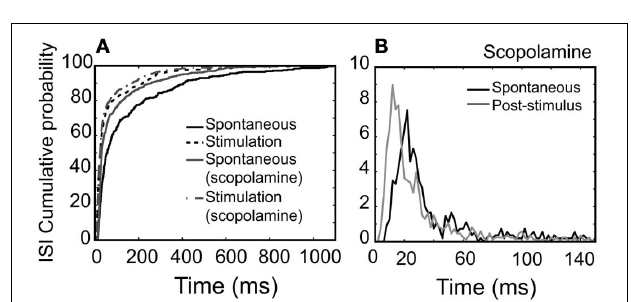
FIGURE 9 | NDB potentiation is not affected by scopolamine in a non-synchronized, rhythmically spiking unit (Figure 4). For this unit, scopolamine was dripped at 600 μ M. (A) Cumulative probability of ISI distributions in spontaneous or post-stimulus activity and the effect of scopolamine. (B) Plots showing ISI distributions after scopolamine treatments. Note that ISIs following NDB stimulation are decreased significantly ( p < 0 . 001), which is not affected by scopolamine ( p < 0 . 001).